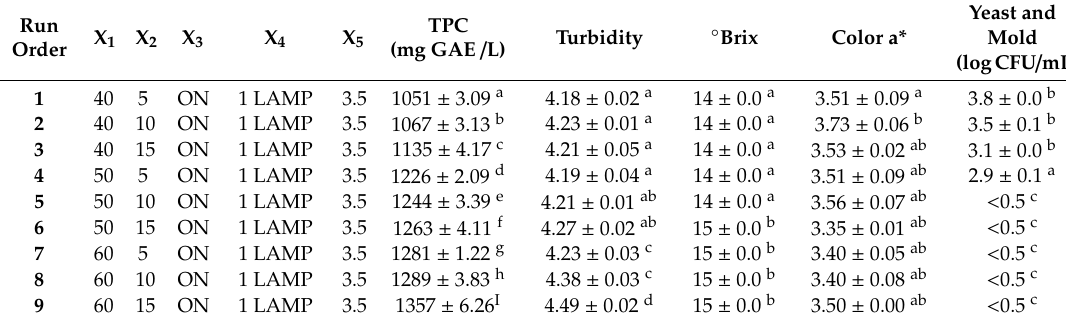
Table 6. Experimental parameters in US + UV pasteurization the observed response values for pomegranate